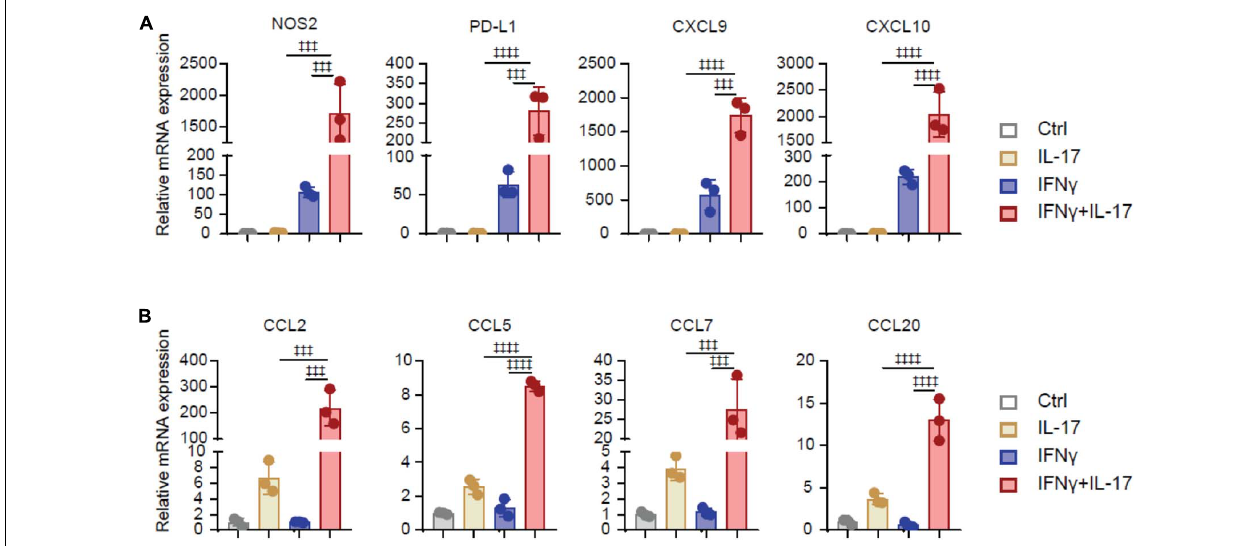
FIGURE 2 | IL-17 and IFN γ synergistically increase immunoregulatory genes in BMSCs. (A,B) The relative mRNA expression level of immunoregulatory molecules (NOS2, PD-L1, CXCL9, and CXCL10) (A) and myelocyte-recruiting chemokines (CCL2, CCL5, CCL7, and CCL20) (B) in the BMSCs treated with IL-17 and IFN γ , respectively, or jointly. Data represent mean ± SD of 3 independent experiments. ‡‡‡ p < 0.001, ‡‡‡‡ p < 0.0001. ns, not